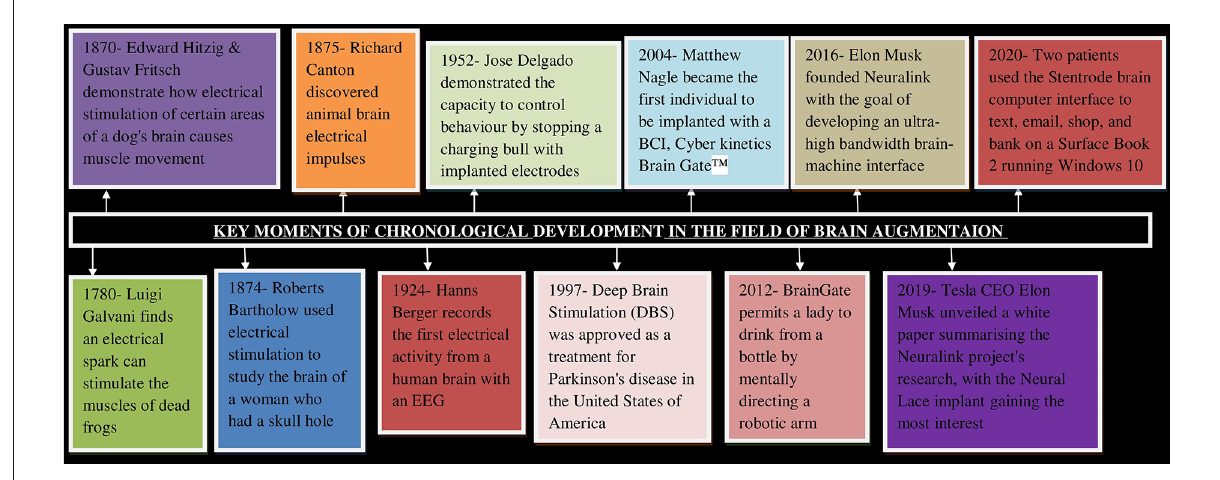
FIGURE1 Milestones of chronological development in the field of Brain Augmentation. Key moments in the history of brain computer interface which eventually leads to the development of brain augmentation techniques for the welfare of humanity so as to mitigate several diseases and neurological disorders. BCI, Brain computer interface; EEG, Electroencephalogram; DBS, Deep brain